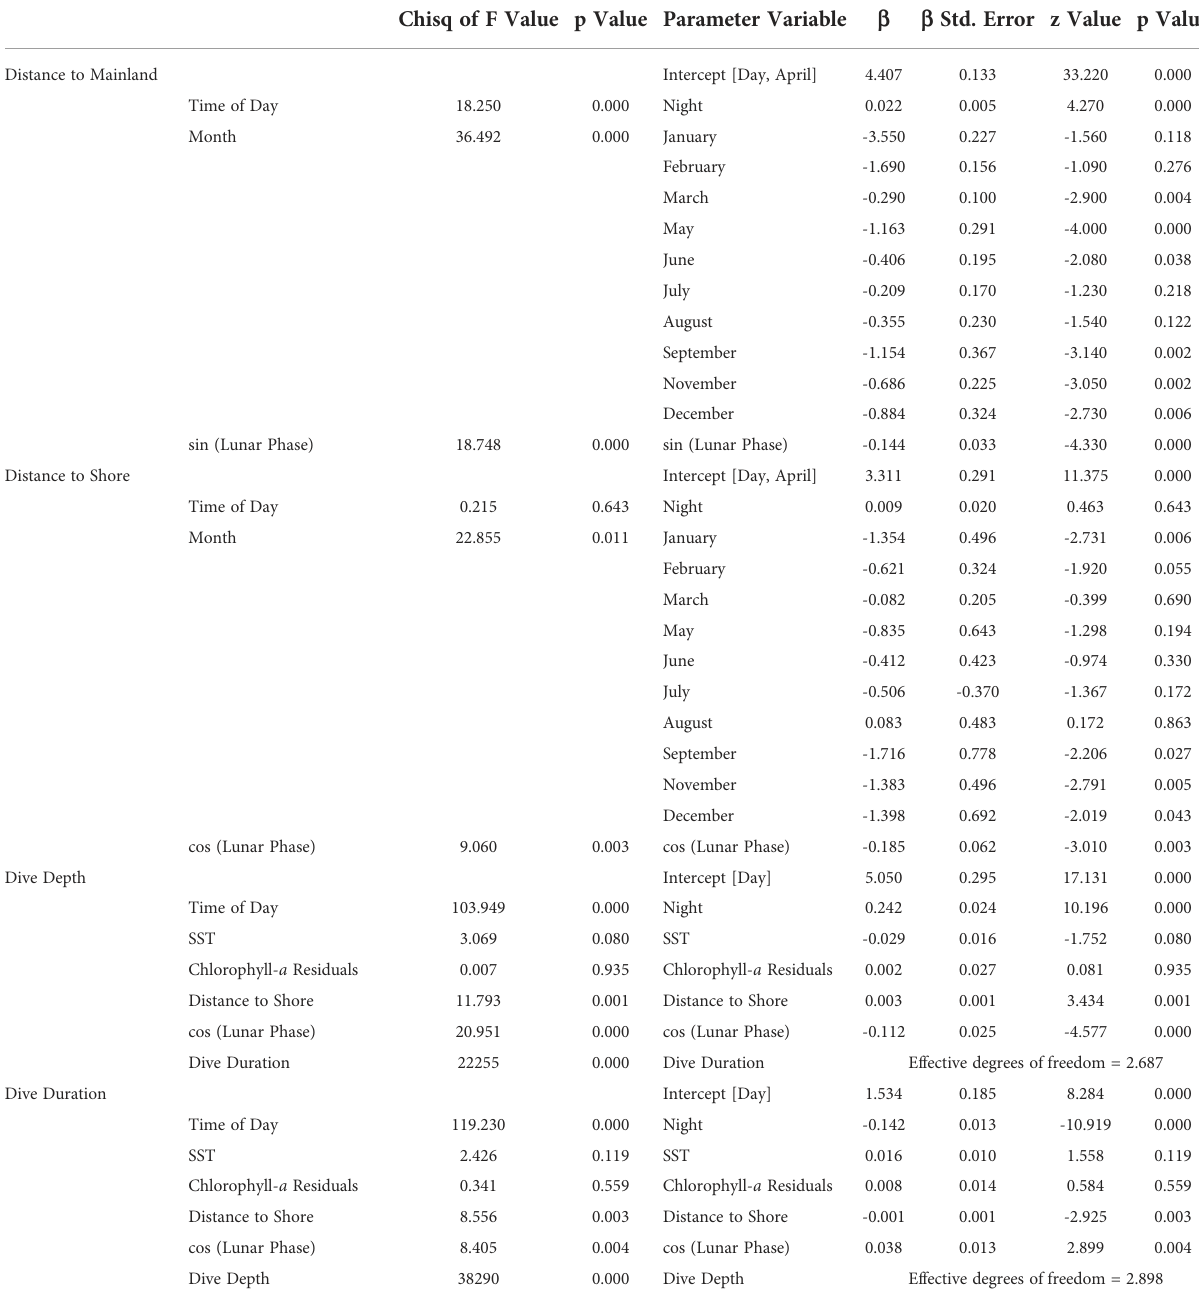
TABLE 3 Model results including type II Wald chi-square (movement models) or Wald F (dive models) testing and parameter estimation with associated signi fi cance